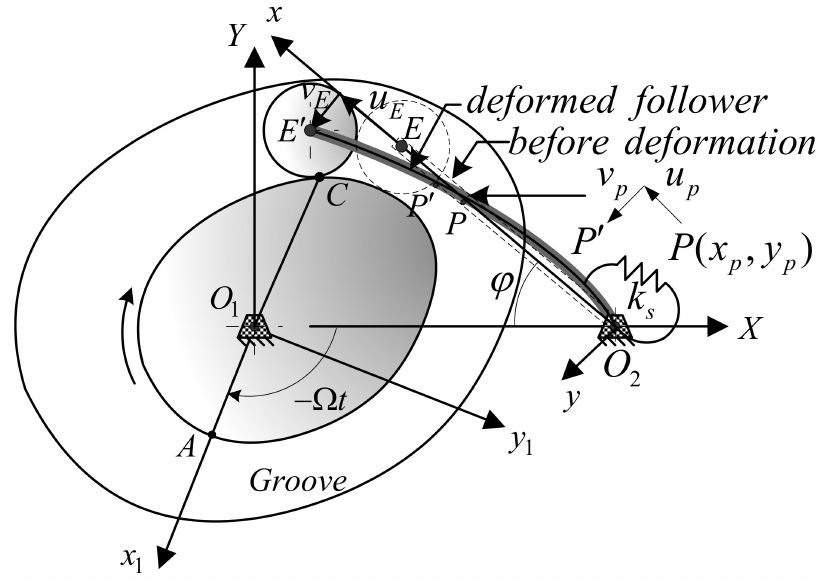
Figure 2. Deformation diagram of the cam